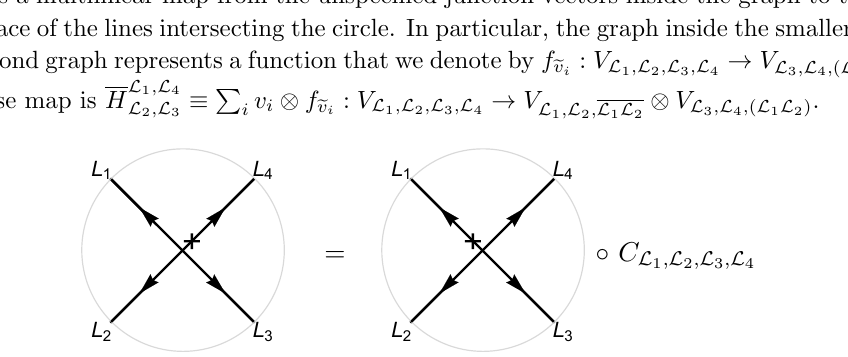
Figure 9 . The cyclic permutation map on an X-junction.